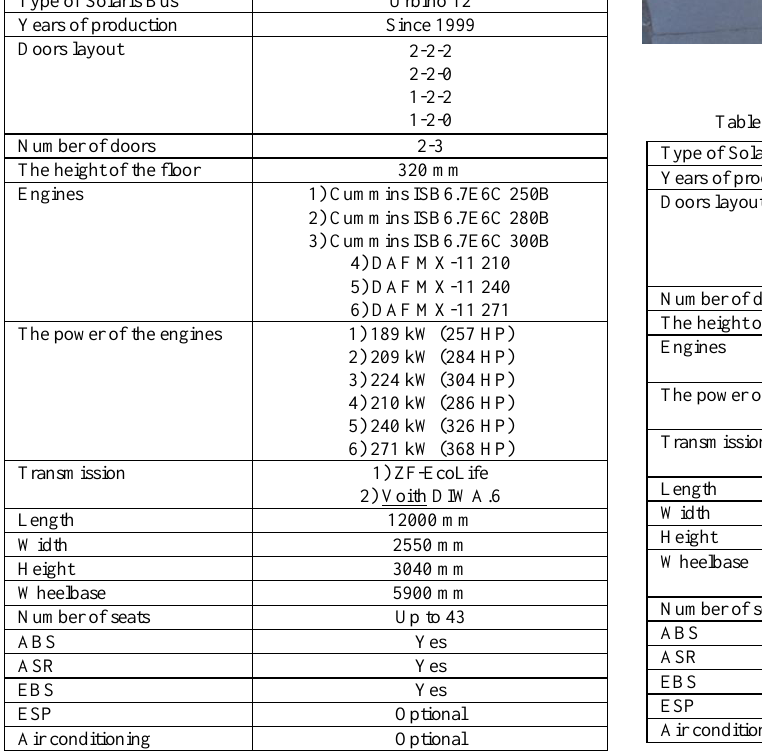
Table 2. Technical data of the Solaris Urbino 12 bus [20]